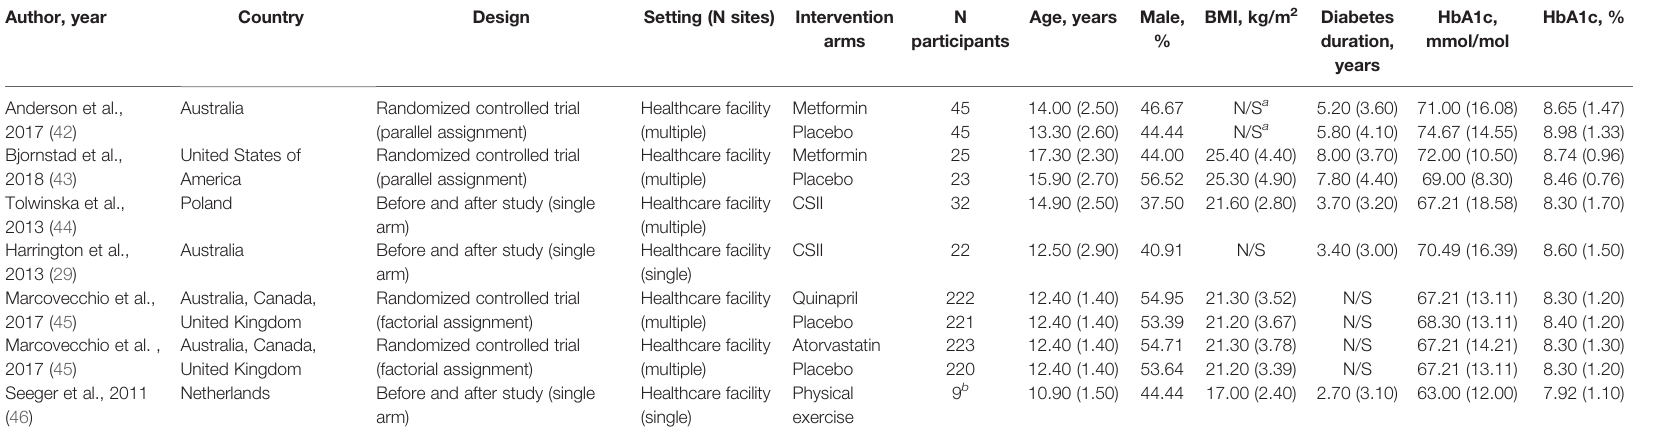
TABLE 1 | Study and patients ’ characteristics at baseline.